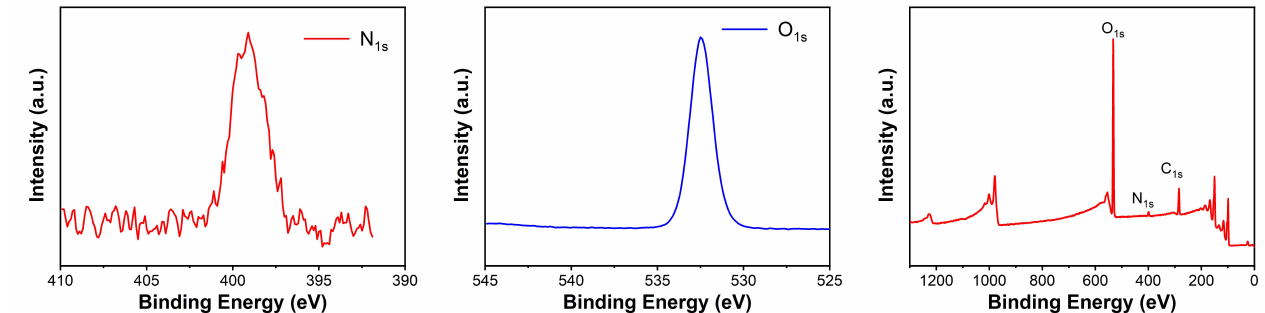
Figure 7. XPS spectra for 3-PANI-CNCs. ( a ) N 1s spectrum, ( b ) O 1s spectrum and ( c ) surface elements analysis spectrum.